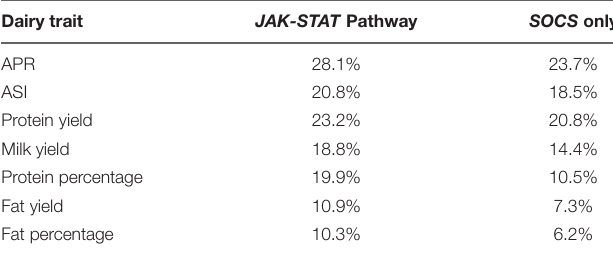
TABLE 4 | Adjusted total variation explained by SNP